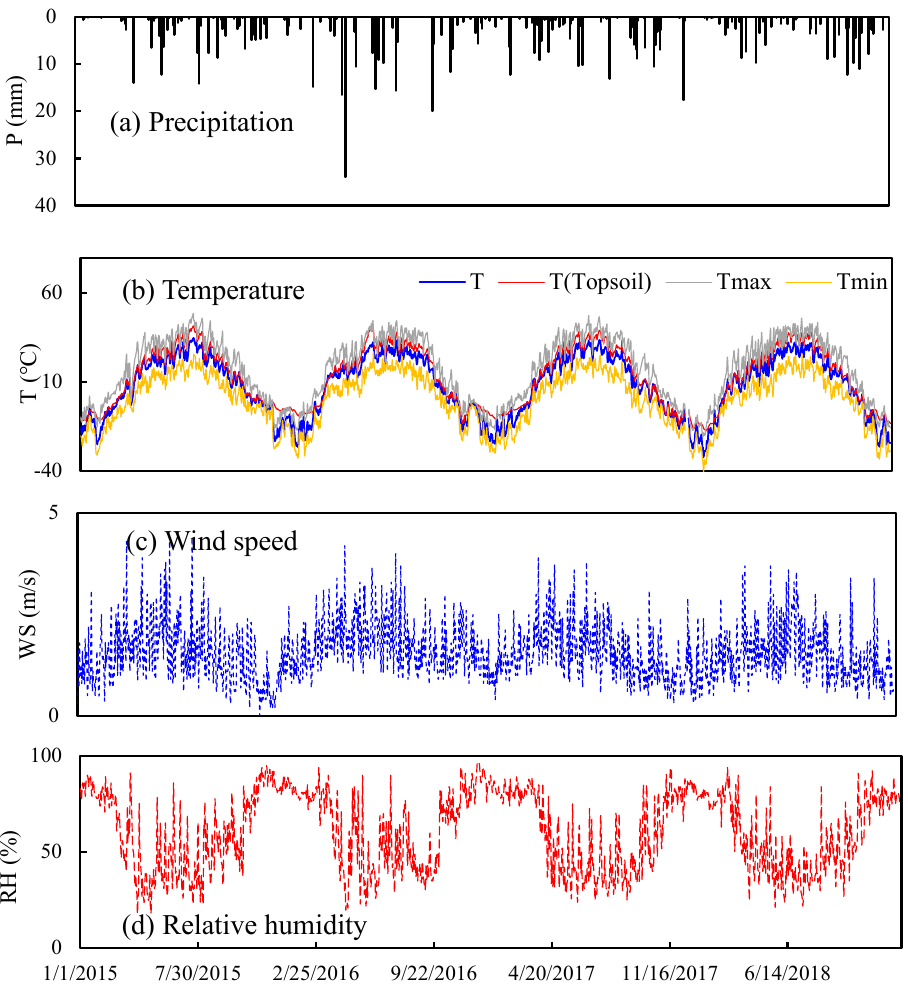
Figure 2. Precipitation ( a ), air temperature and soil temperature ( b ), wind speed ( c ), and relative humidity ( d ) in the study area from 2015 to 2018 (P , precipitation in mm/d; T , temperature in °C ; WS , wind speed in m/s; RH , the relative humidity in %) .